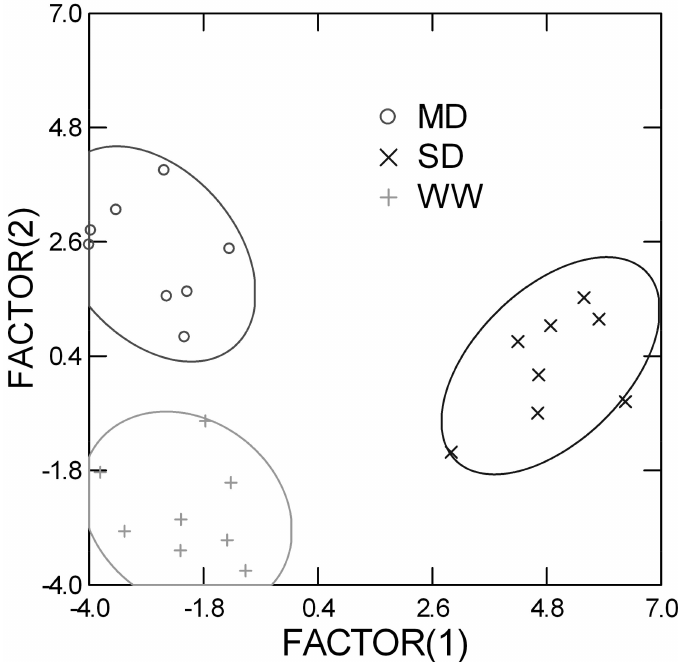
Figure 5. Canonical score plot from linear discriminant analysis of metabolites detected in leaves of loquat plants under well-watered conditions (WW), mild drought (MD) and severe drought (SD) during the four months of